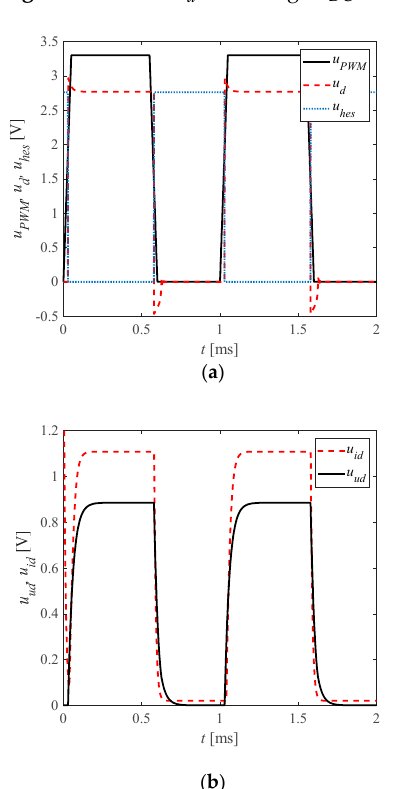
d vs. voltage u DC .